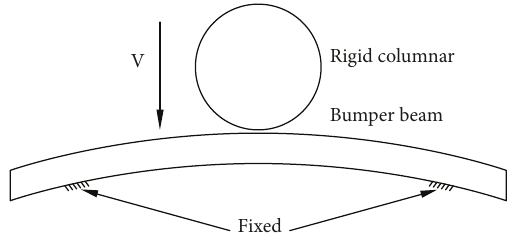
Figure 13: The schematic diagram of columnar collision.